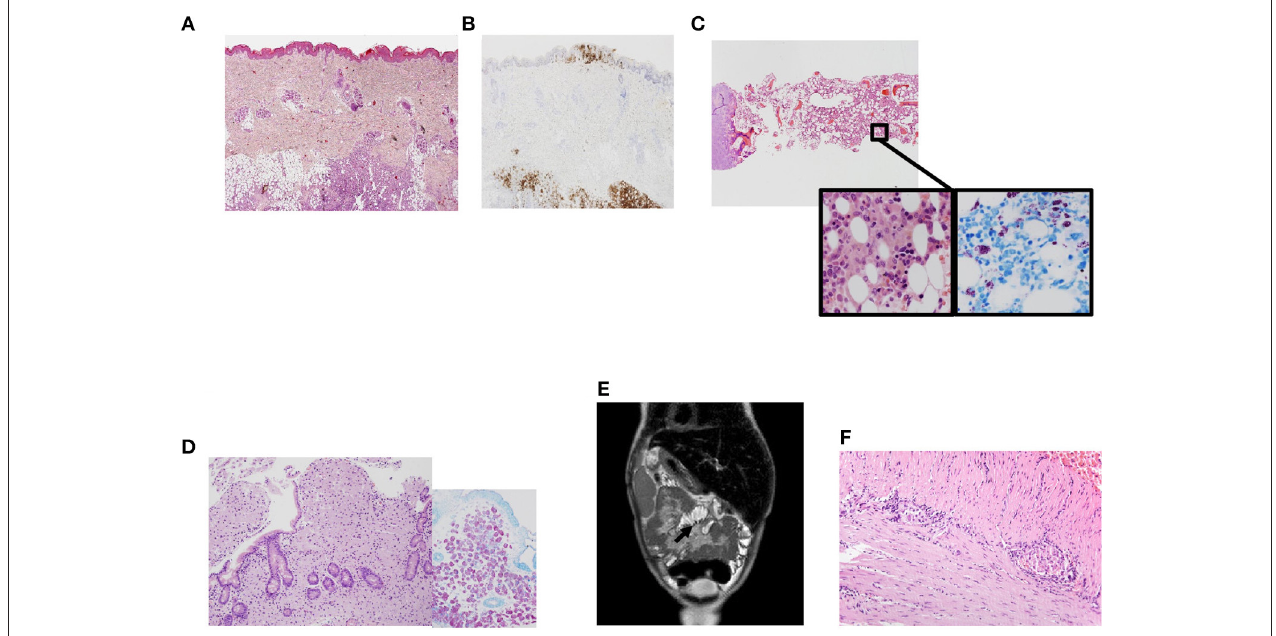
FIGURE 1 | Clinical phenotype in a patient with NF- κ B1 deficiency. (A) Skin biopsy showing a dense cellular infiltrate by Langerhans cells. Magnification 200 × . Hematoxilin-eosin; (B) Skin biopsy with Langerhans cells infiltrating epidermis and subcutaneous tissues, positive to CD1a. Magnification 200 × . Immunohistochemistry CD1a; (C) Panoramic view of bone marrow with many histiocytes with granular cytoplasm. Magnification 40 × . Inside images: high power view of histiocytes between hematopoietic cells. They were intensely positive with acid-alcohol techniques (Ziehl Nielsen). Magnification 400 × . Hematoxilin-eosin and Ziehl Nielsen; (D) Panoramic view of duodenal biopsy with villi shortened and lamina propria expanded by many granular histiocytes that stained positive with Ziehl Nielsen to detect Acid-resistant bacilli (inside). Magnification 200 × . Hematoxilin-eosin. Inside Ziehl-Nielsen. Magnification 200 × (E) Post-contrast coronal T2-weighted MRI of the abdomen showing mesentery enhancement. (F) Small bowel biopsy showing myenteric plexus with lymphoplasmocitoid inflammatory cells. Magnification 200 × .